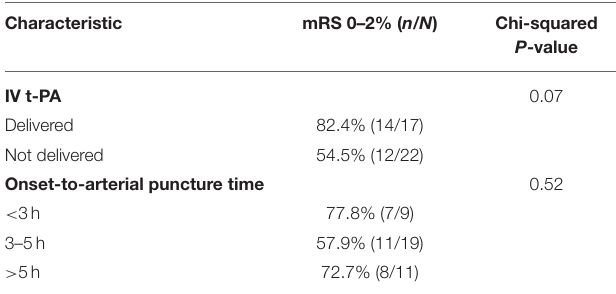
TABLE 4 | Proportion of patients with 90-day functional independence (mRS 0–2) based on procedure characteristics among the PC